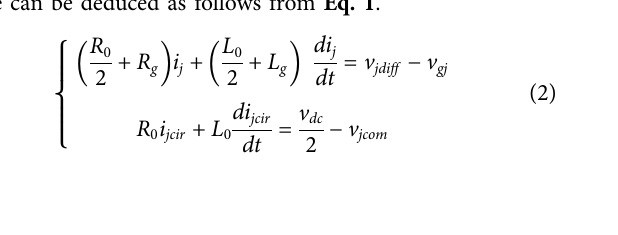
Frontiers in Energy Research |